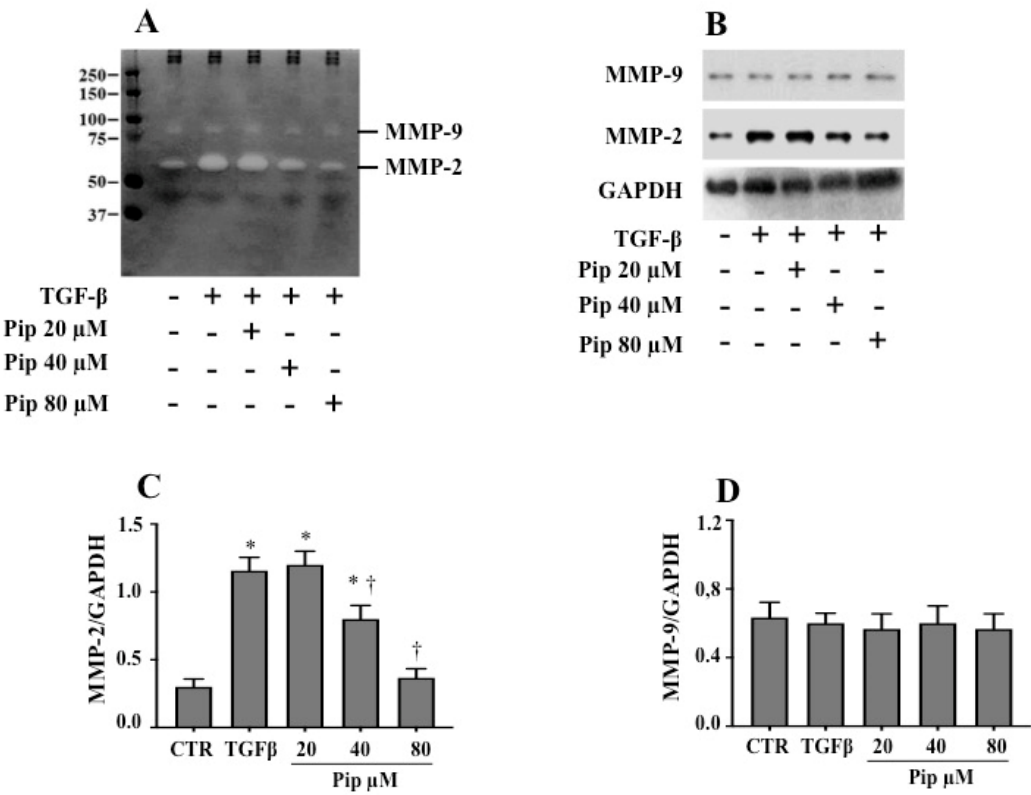
Figure 6. Pretreatment with piperine inhibits MMP-2 activity and expression in A549 cells treated with TGF- β 1. A549 cells were pretreated with non-cytotoxic doses of piperine (20, 40 and 80 µ M) for 24 h, followed by treatment with 1 ng / mL TGF- β 1 for 48 h. ( A ) After treatments, gelatin zymography was employed to detect MMP activity. ( B ) Western blot analysis to investigate the expression of MMP-2 ( C ) and MMP-9 ( D ) was performed by using the cell culture medium. The maximum volume of supernatant used to analyze the activity and expression of MMPs was 30 µ L. The volume of each experimental point was adjusted based on the amount of protein in the cell lysates. The results are representative of three independent experiments. Quantitative Western blot analyses are shown as mean ± SD. * p ≤ 0.05 vs. untreated cells (CTR), † p ≤ 0.05 vs. TGF- β .